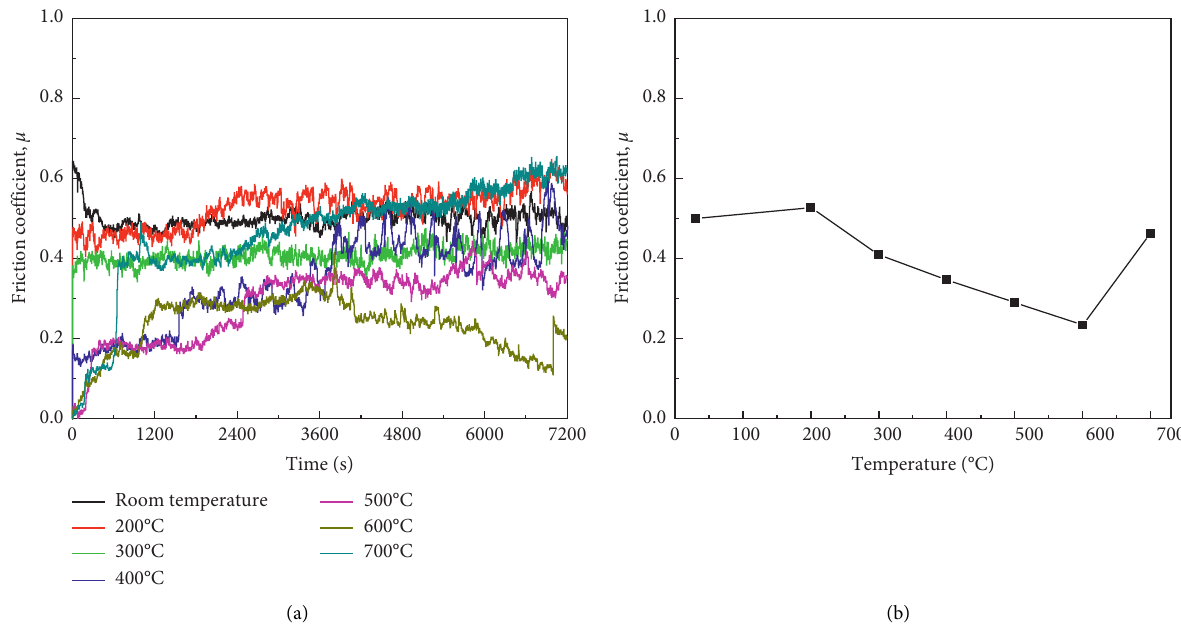
Figure 9: Friction coefficients of S0 coating: (a) From room temperature to 700 ° c and (b) the average friction